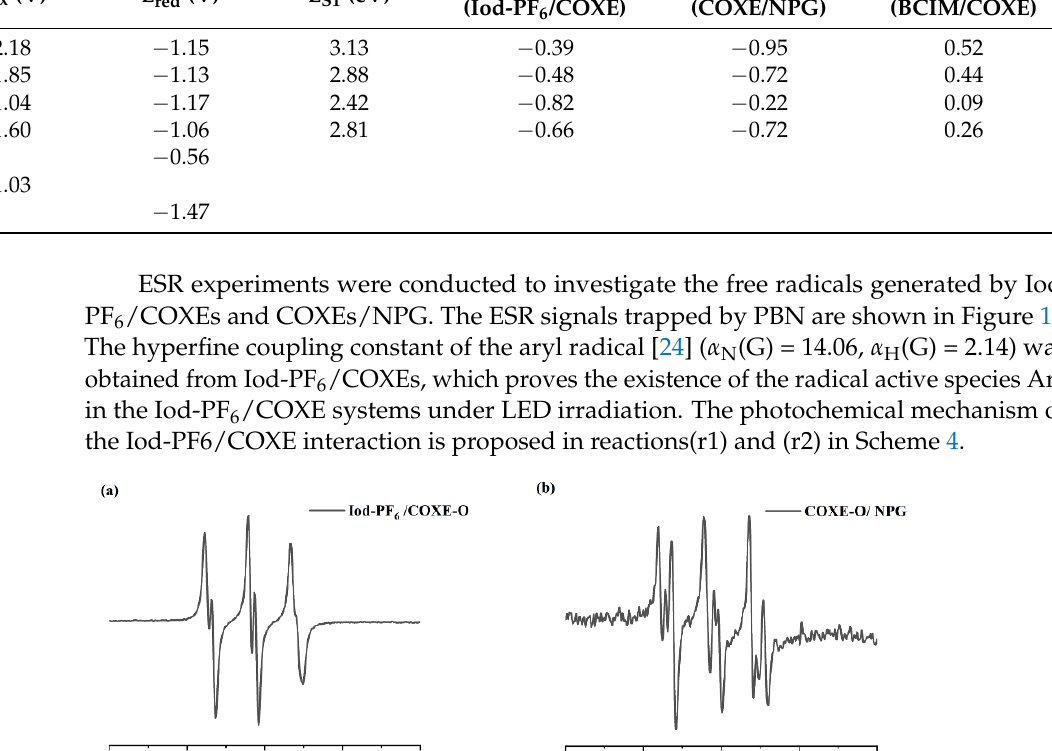
Scheme 4. Proposed photochemical mechanisms for the Iod-PF 6 /COXE systems.